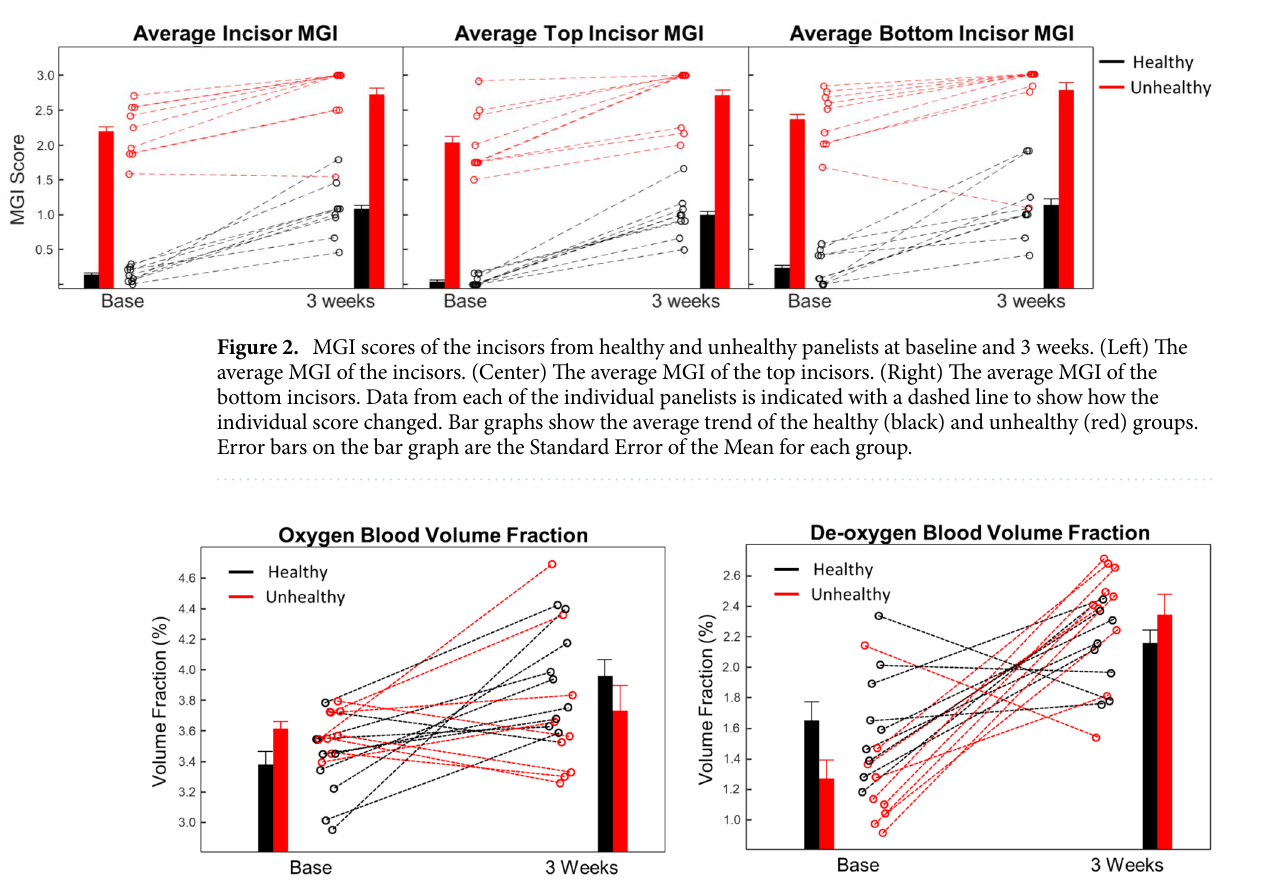
Figure 3. Spatial frequency domain blood volume measurements of healthy and unhealthy panelists at baseline and 3-weeks. (Left) Oxygenated blood volume fraction for each panelist. (Right) De-oxygenated blood volume fraction for each panelist. Data from each of the individual panelists is indicated with a dashed line. Solid lines show the average trend of either the healthy (black) or unhealthy (red). Error bars are standard error of the